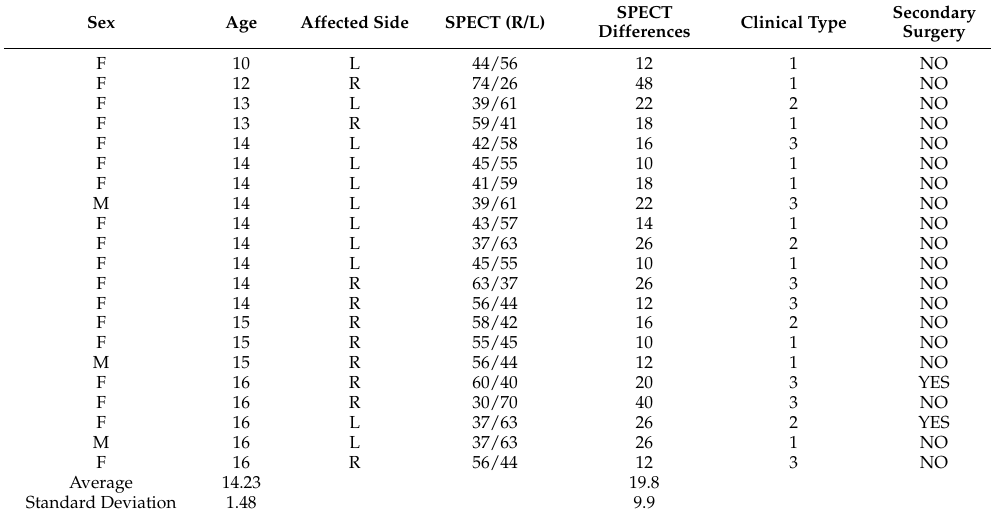
Table 5. Distribution of subjects with UCH between 10 and 16 years old.